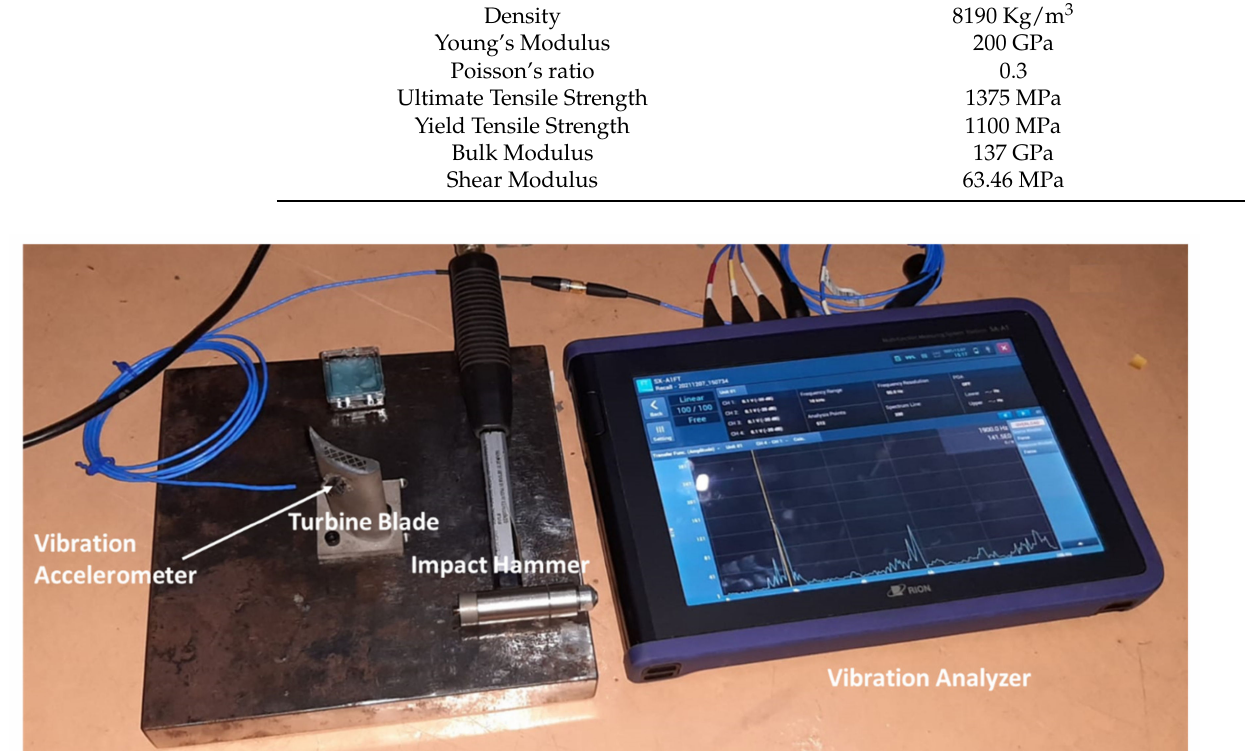
Figure 3. Experimental modal analysis test